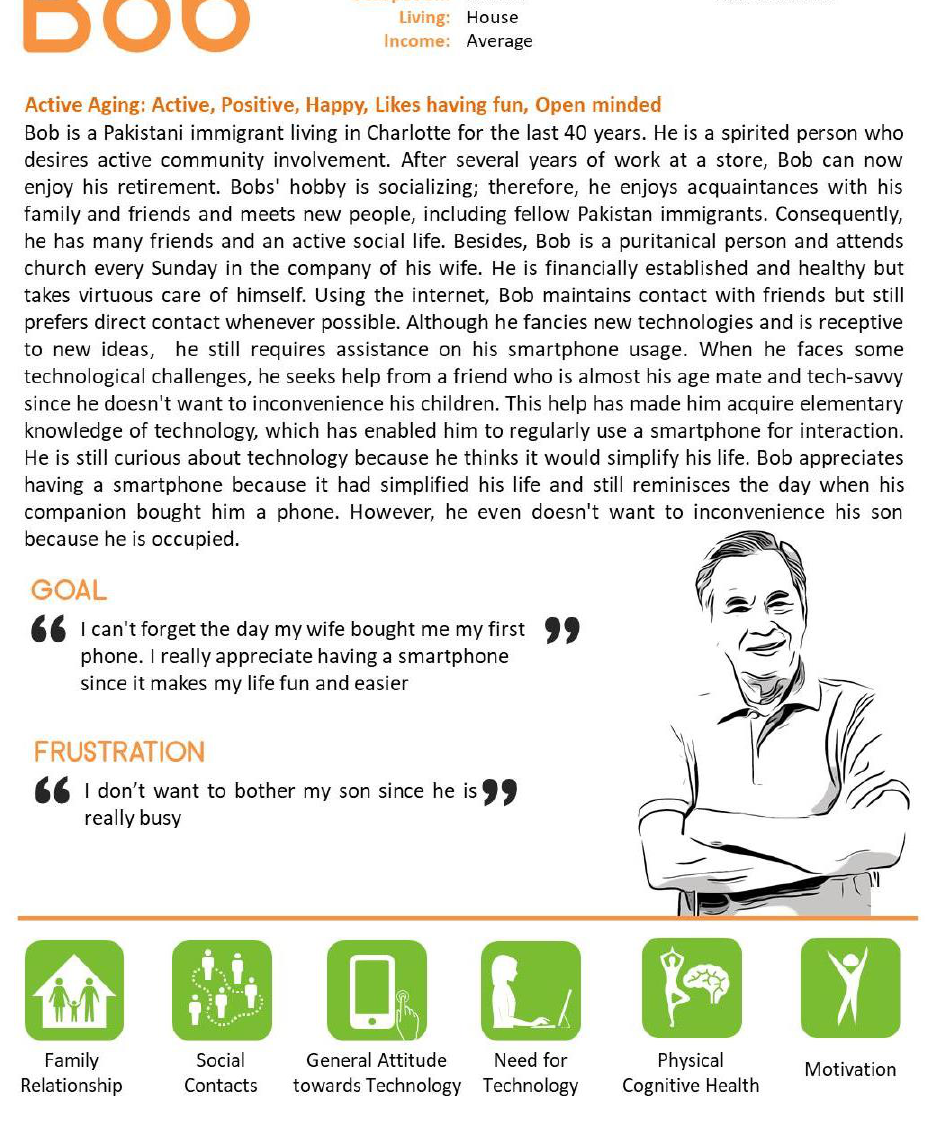
Figure 1. Case 1—Representative character to present positive attitude towards technology.